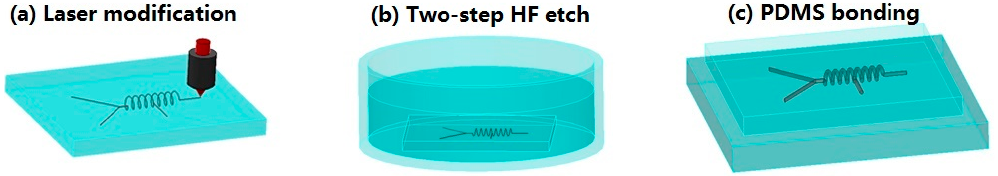
Figure 1. Schematic diagram of the fabrication process. ( a ) Laser modification with accurate dynamic laser power regulation; ( b ) 5% HF wet etch for 1 h and 10% HF wet etch for 2 h; and ( c ) oxygen plasma assisted encapsulation.